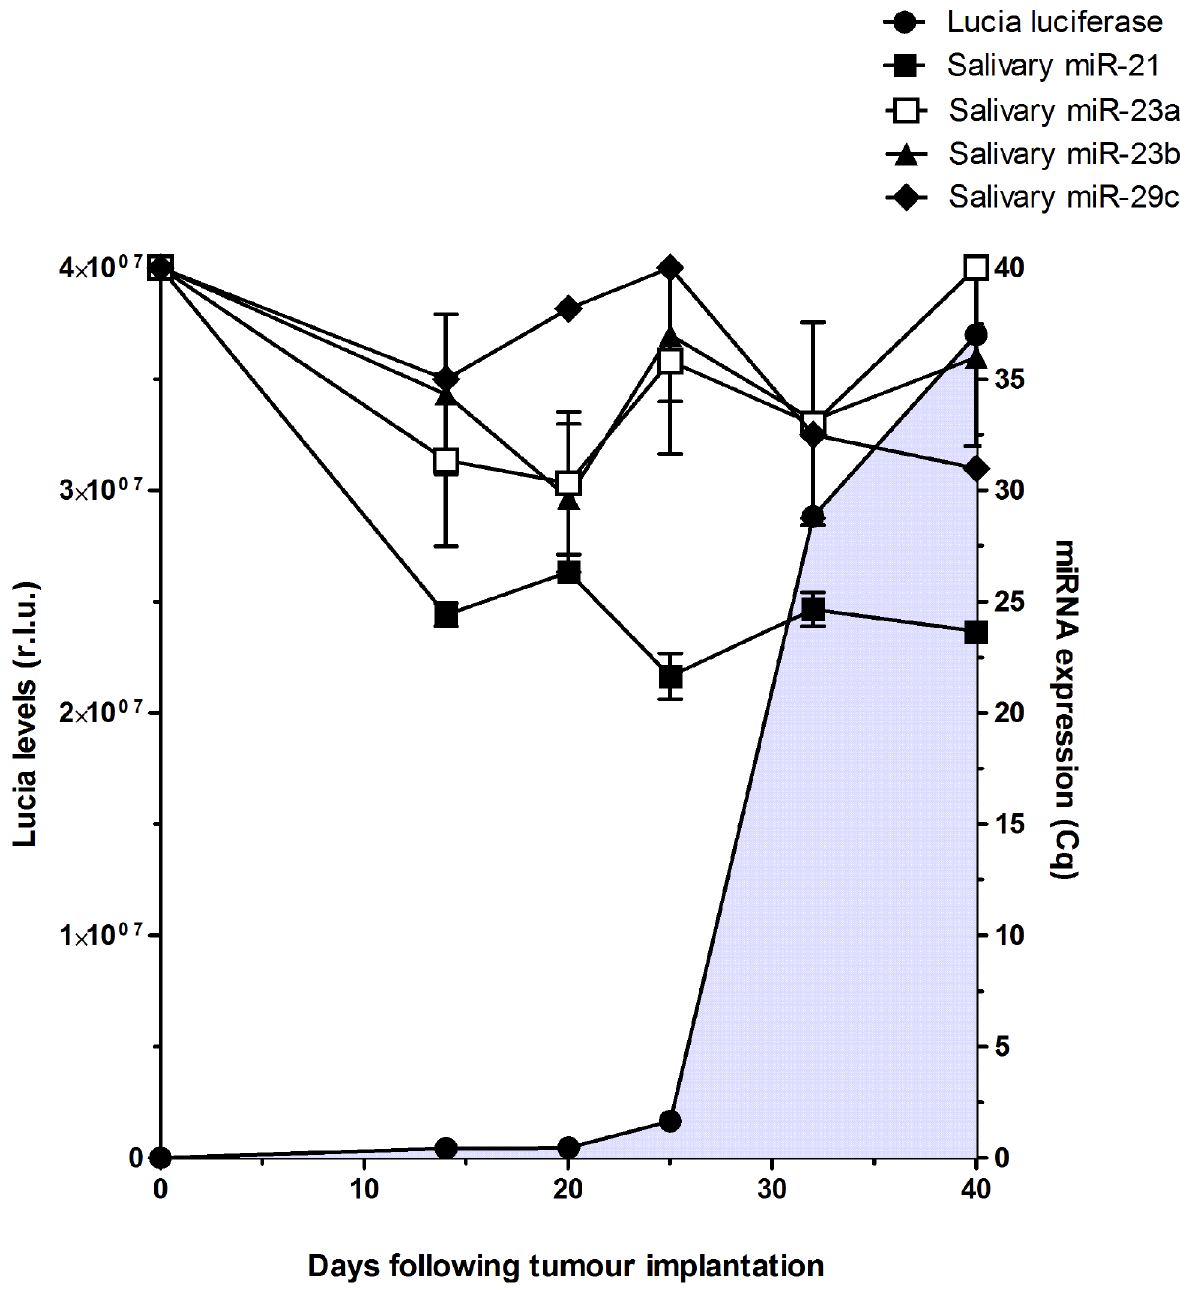
Fig 2. Analysis of salivary hsa-miR-21, hsa-miR-23a, hsa-miR-23b and hsa-miR-29c levels and Lucia blood levels in mice xenografted with Mia PACA-2 Lucia cells at the time indicated following tumor induction. Results are mean ± S.D. of 6 biological replicates done in experimental triplicates. miRNA levels are expressed in Cq, Lucia levels are expressed in relative light units (r.l.u.). The grey zone corresponds to tumor detection using secreted Lucia as a systemic, protein-based tumor